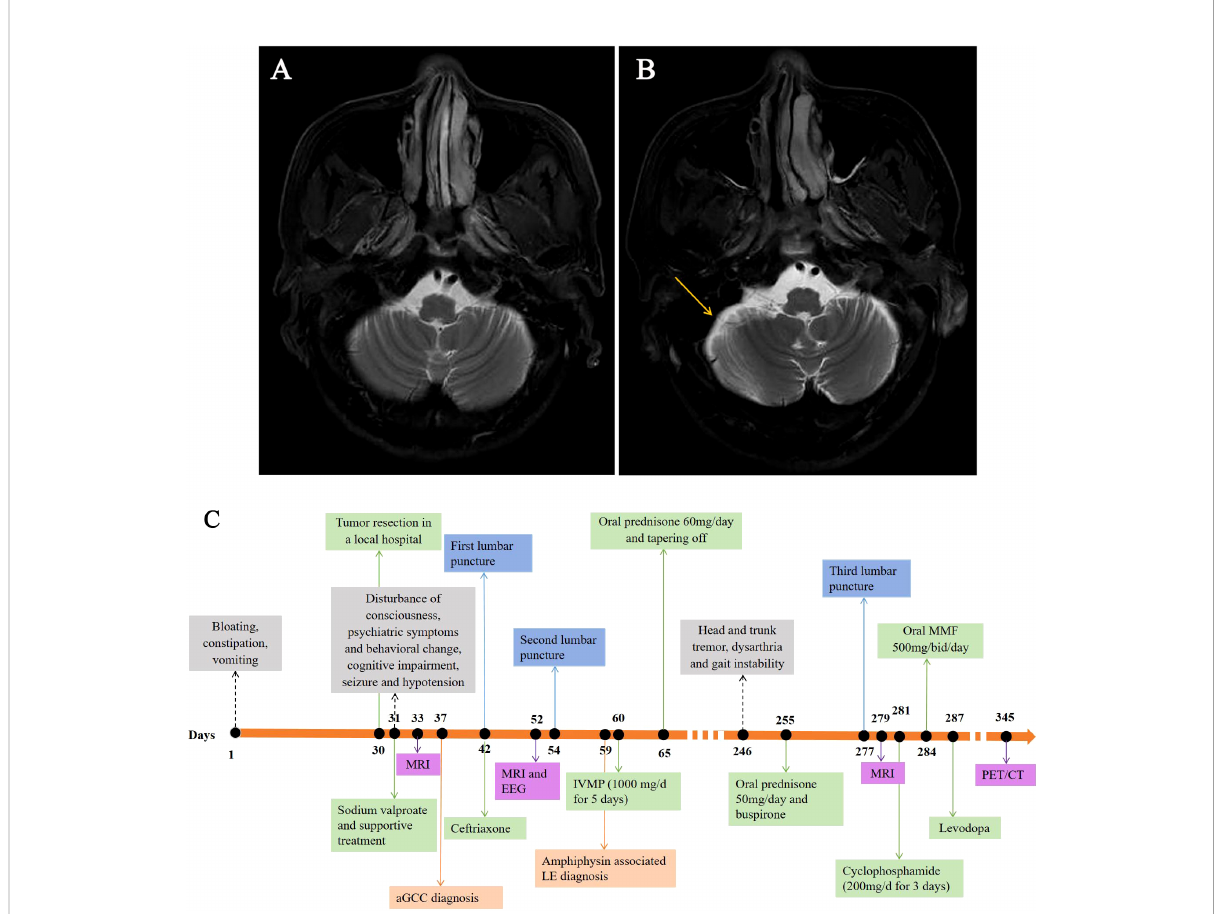
FIGURE 1 Brain MRI scans obtained from the patient and timeline of his clinical course. Despite there being no speci fi c fi ndings upon an initial T2- weighted MRI (A) , mild cerebellar atrophy was observed in the subsequent axial T2-weighted MRI performed seven months later ( B , yellow arrow). Timeline of the patient ’ s clinical course highlighting the manifestation, auxiliary examination, treatment and diagnosis time (C) . EEG, electroencephalograph; LE, limbic encephalitis; MMF, mycophenolate mofetil; MRI, magnetic resonance imaging; IVMP, intravenous methylprednisolone; PET/CT, positron emission tomography with computed